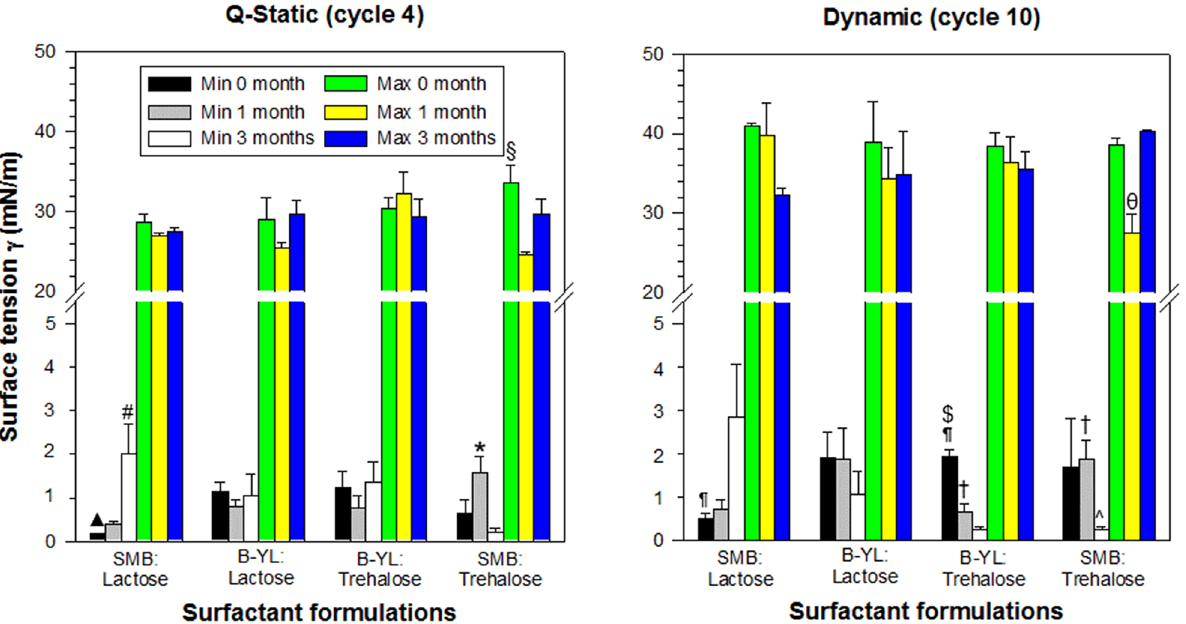
Figure 5. Mean ± SEM quasi-static (cycle 4) and dynamic (cycle 10) cycling data of the four dry powder surfactant preparations from the 2nd series at captive bubble surfactometry. Surfactant formulations included SMB: Lactose, B-YL: Lactose, B-YL: Trehalose and SMB: Trehalose. The left-sided figure depicts minimum and maximum surface tension values at quasi-static cycle 4 and the right-sided figure shows minimum and maximum surface tension values at dynamic cycle 10 after 0, 1 and 3 months of exposure to 40 °C and 75% relative humidity (n = 3–4). Min = mimimum, max = maximum; # p = 0.021 for QS min 0 vs 3 months of SMB: Lactose; * p = 0.024 for QS min 1 vs 3 months for SMB: Trehalose; ▲ p < 0.02 for QS min 0 month of SMB: Lactose vs B-YL: Lactose and B-YL: Trehalose; § p = 0.017 for QS max 0 vs 3 months of SMB: Trehalose; ¶ p = 0.003 of DC min 0 months for SMB: Lactose vs B-YL: Trehalose; † p = 0.048 of DC min 1 month of B-YL: Trehalose vs SMB: Trehalose; $ p < 0.01 of DC min 0 month vs 1 and 3 months for B-YL: Trehalose; ^ p < 0.03 of DC min 3 month vs 0 and 1 month for SMB-Trehalose; θ: p < 0.02 of DC max 1 month vs 0 and 3 months for SMB: Trehalose. See Table 1 for details on composition of the